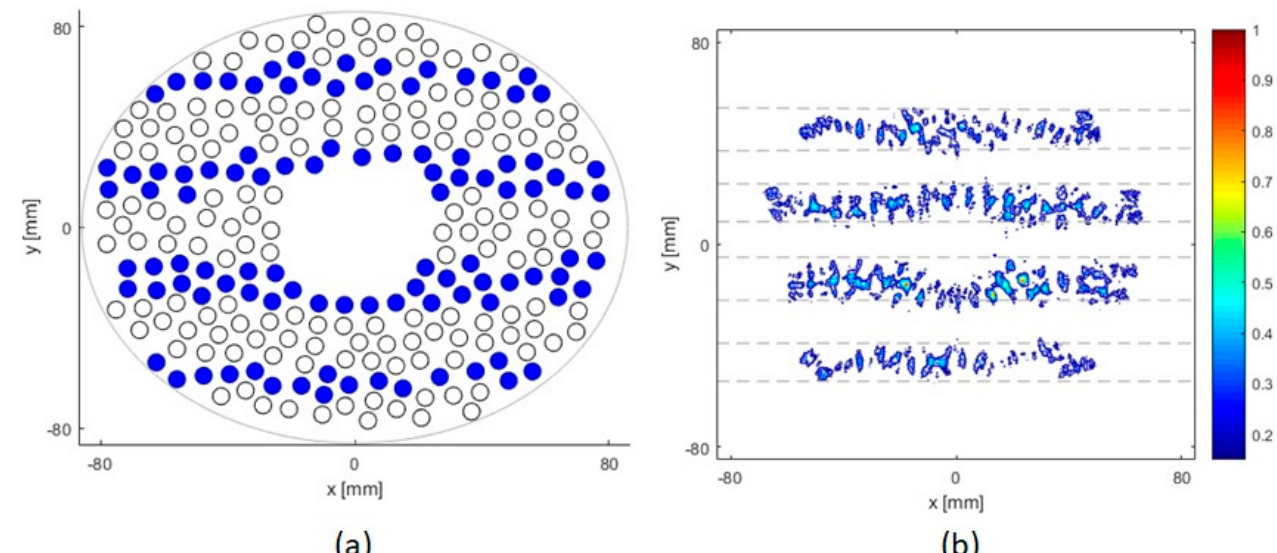
Figure 4. ( a ) Distribution of active elements of the array. Filled circles denote active elements. The number of active elements is 100. ( b ) Predicted intensity distribution in the ribs plane for a single focus generated at the center of curvature of the array (0, 0, 130) mm when the rib phantom was placed at 40 mm depth from the center of the array. Striped intensity distribution suggests that the energy is delivered only through the spaces between the ribs. Table 1. Intensity distribution and focal quality for different ribs geometry configuration positioned at three different depths (40 mm, 70 mm, 100 mm) from the array center, when the beam axis passes through the middle of one of the ribs (case I) and middle of the intercostal space (case II). Strip width is the width of the strips in terms of the intercostal edge–edge spacing d . The results shown are for a single focus targeted at the geometric focus of the array. Depth Case